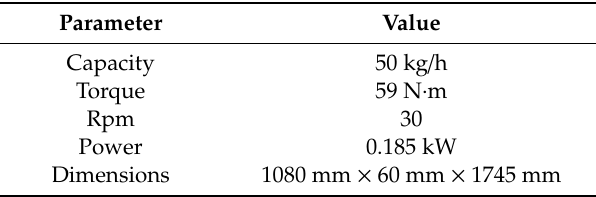
Table 8. Technical data of the machine